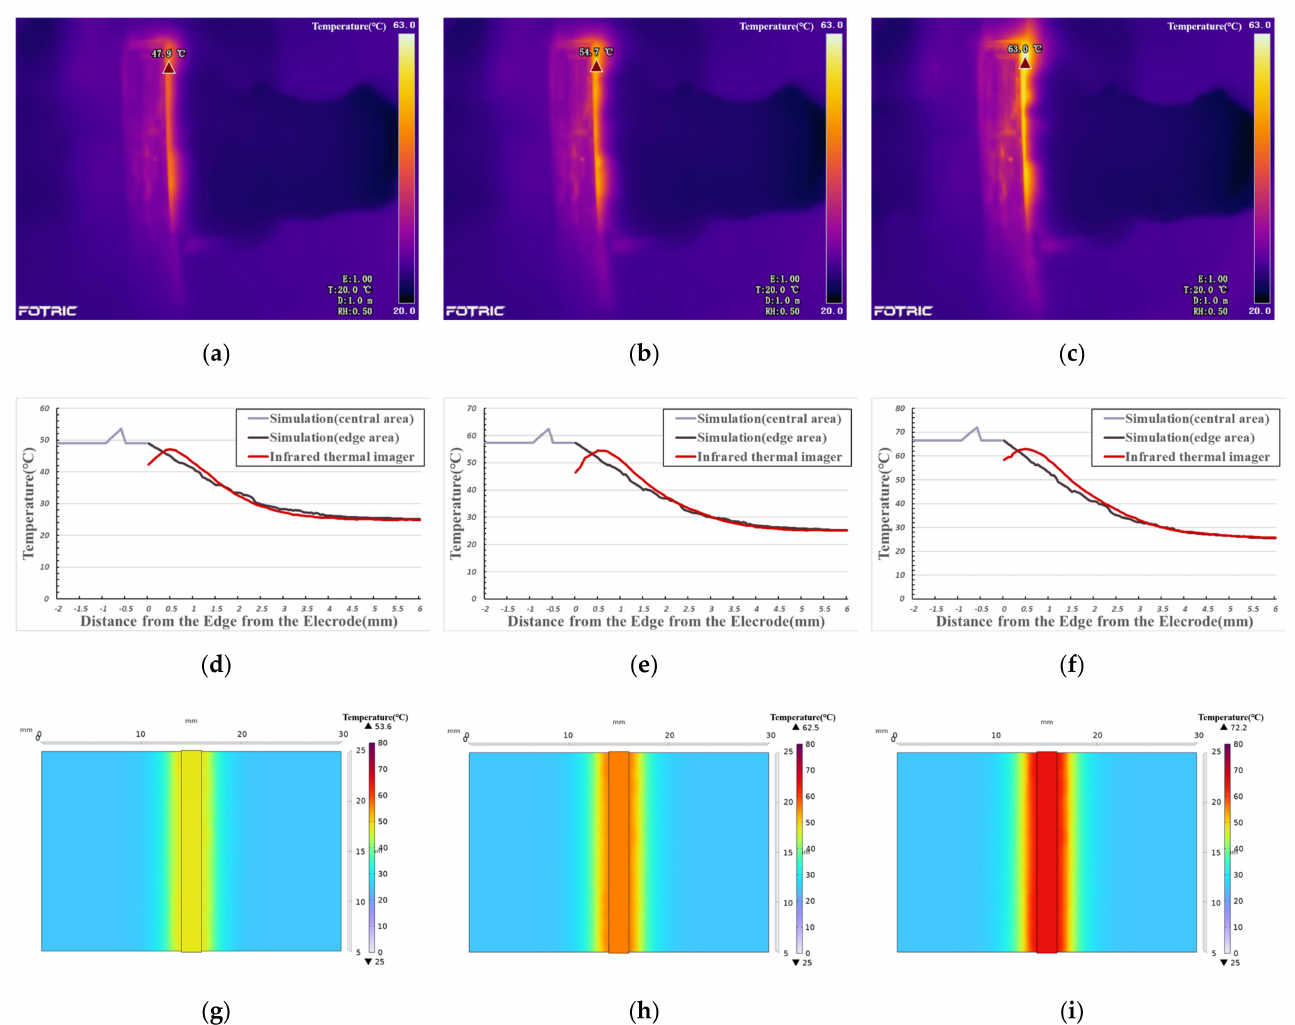
Figure 6. ( a ): Thermal image (20 s); ( b ): Thermal image (25 s); ( c ): Thermal image (30 s); ( d – f ): Temper- ature comparison curve between infrared thermal imager data and simulation data; ( d ): 20 s; ( e ) 25 s; ( f ): 30 s; ( g – i ): Simulation image of temperature distribution with the same visual angle as thermal image. ( g ): corresponds to ( a ), 20 s; ( h ): corresponds to ( b ), 25 s; ( i ): corresponds to ( c ), 30